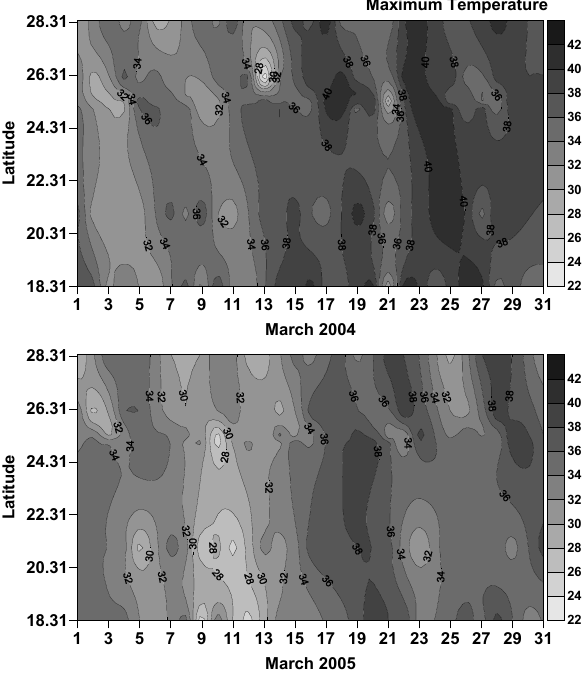
Figure 2b Fig. 2. The 850hPa vector winds over the Indian continental re- gion (5 ◦ –40 ◦ N; 60 ◦ –100 ◦ E) during (a) March 2004 and during Figure 4 Fig. 4. Latitude-time cross sections of the daily maximum surface (b) March 2005. temperature ( ◦ C) distribution over Indian longitudes in March 2004 (top panel) and March 2005 (bottom